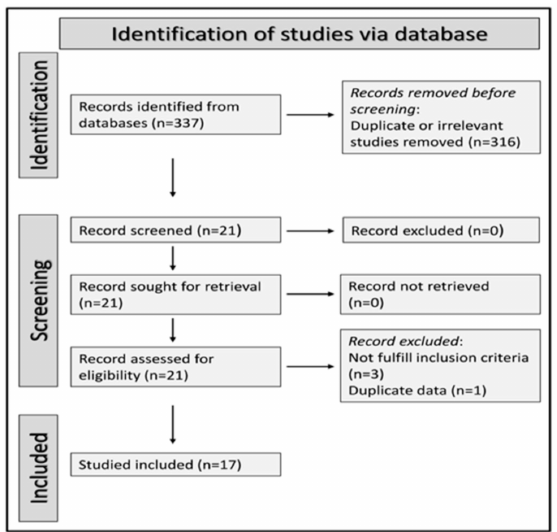
Figure 1. PRISMA 2020 flow